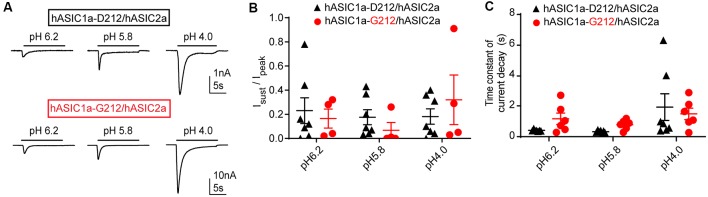
Properties of ASIC1a/ASIC2a heteromers. The data are from CHO cells transfected with hASIC1a-D212/hASIC2a (black symbols) and hASIC1a-G212/hASIC2a (red symbols), measured with whole-cell patch-clamp. (A) Current traces of hASIC1a-D212/hASIC2a (top) and hASIC1a-G212/hASIC2a activation (bottom), obtained with stimulation pH values as indicated, from conditioning pH 7.4. The acidic pH was applied for 10 s with a sweep interval of 40 s. (B) Sustained/peak current ratio at the indicated stimulation pH, n = 4–7. The sustained current was measured during the last second of the 10-s acidification. There was no significant difference between the Isust/Ipeak ratio of the two channel types at any pH measured (Two-way ANOVA, followed by Sidak post-test). (C) Time constant of current decay, as obtained from single exponential fits, at the indicated pH, n = 6–7. There was no significant difference in the time constant of current decay between the two channel types at any pH measured (Two-way ANOVA, followed by Sidak post-test).